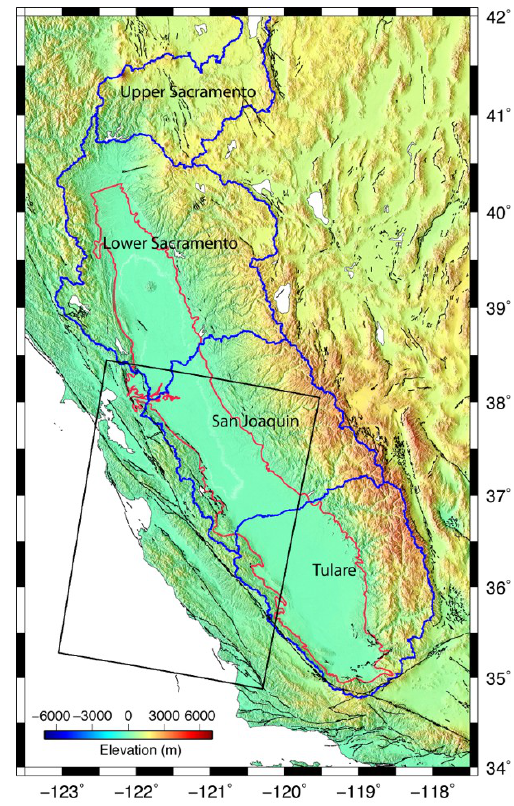
Figure 1. Regional map of the Central Valley region in California with topography in color and shaded‐relief. The black lines are the plate boundary fault system. The red line outlines the Central Valley basin. Blue lines represent the Tulare, San Joaquin, and Sacramento basins, including upper and lower Sacramento basins. The black box indicates the ground footprint of the Sentinel‐1 descending track 42 used in the study.